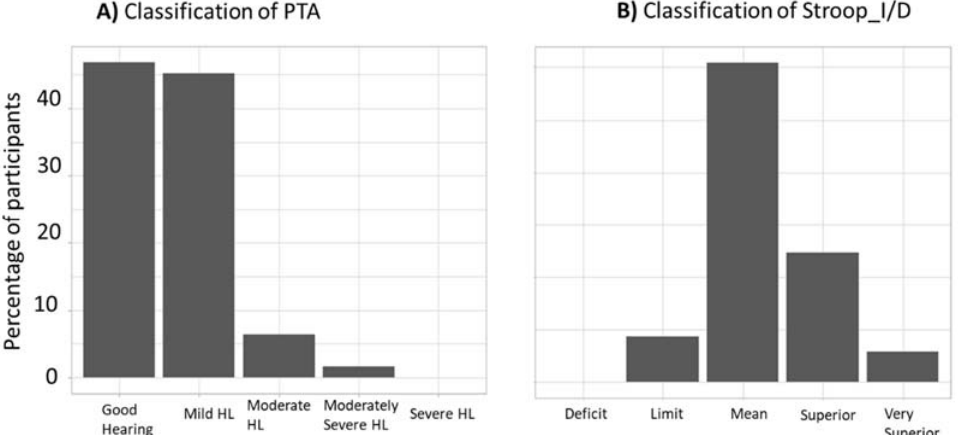
Figure 2. Hearing loss (HL) and Stroop score characterization of EG. ( A ) Classification of the PTA according to the WHO scale, for EG. ( B ) Classification of the Stroop_I/D according to the model built in the study of Bayard et al. [57], for elderly participants. This model allows the categorization of the Stroop_I/D score as a function of the participant’s age above 50 years. The score can be classified into